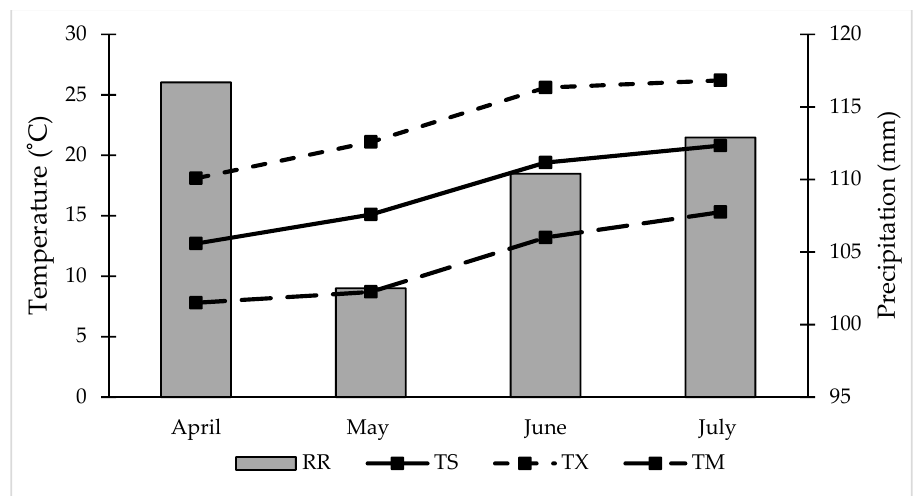
Figure 1. Monthly meteorological data from April to July 2014 for the Novo Mesto meteorological station. Data were obtained from the Environmental Agency of the Republic of Slovenia (ARSO, 2014). TS, mean monthly air temperature; TX, mean daily maximum temperature; TM, mean daily minimum temperature; RR, precipitation.